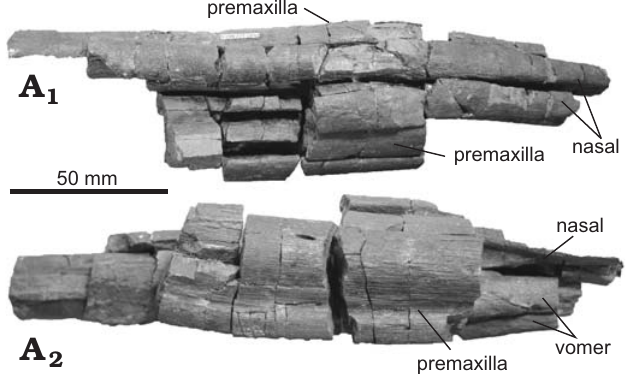
Fig. 4. Rostrum fragment of ophthalmosaurid ichthyosaur Keilhauia sp. ( PMO 222.667) from Spitsbergen, Svalbard, Slottsmøya Member Lager- stätte, Tithonian. Pre maxil lae, nasals, and vomer in dorsal (A 1 ) and lateral (A 2 ) views. Anterior to the right.